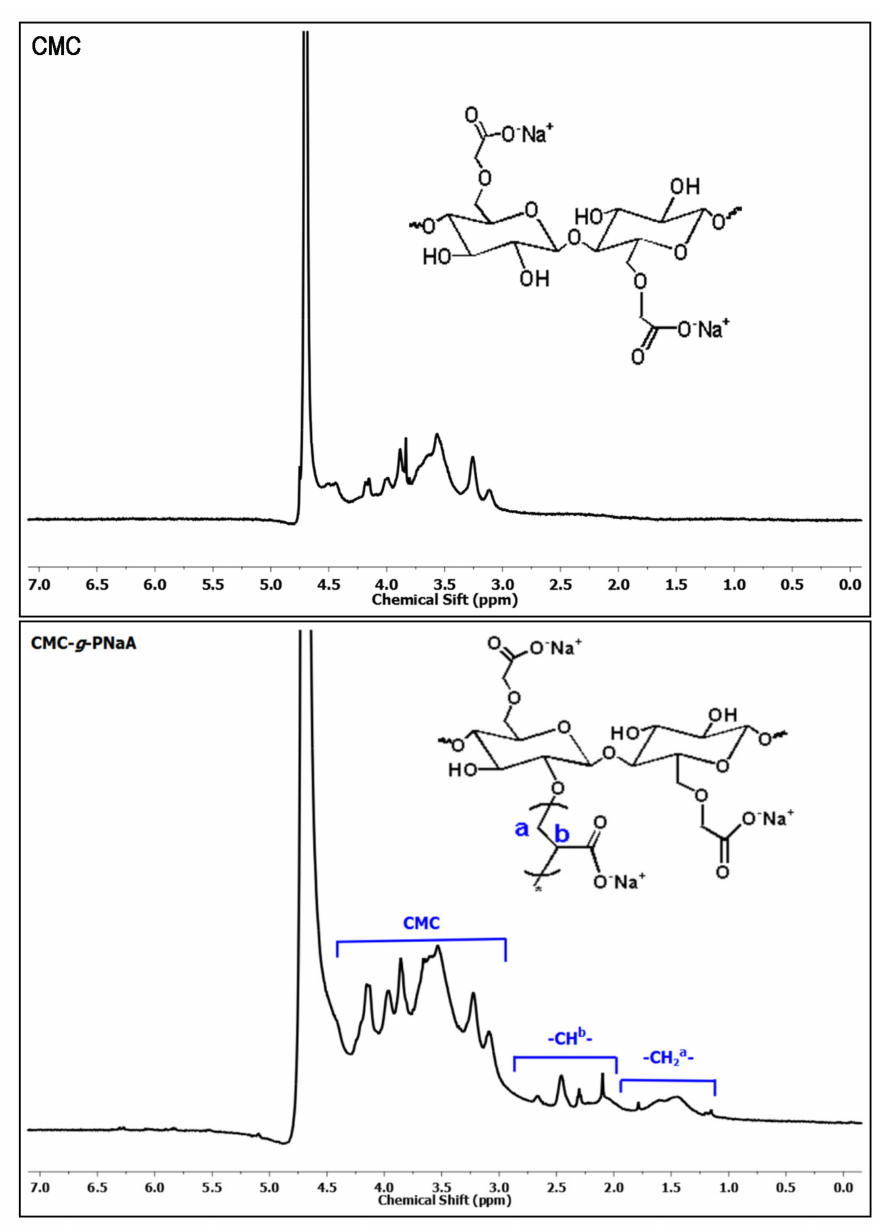
Figure 2. 1 H nuclear magnetic resonance (NMR) spectrum of CMC and CMC- g